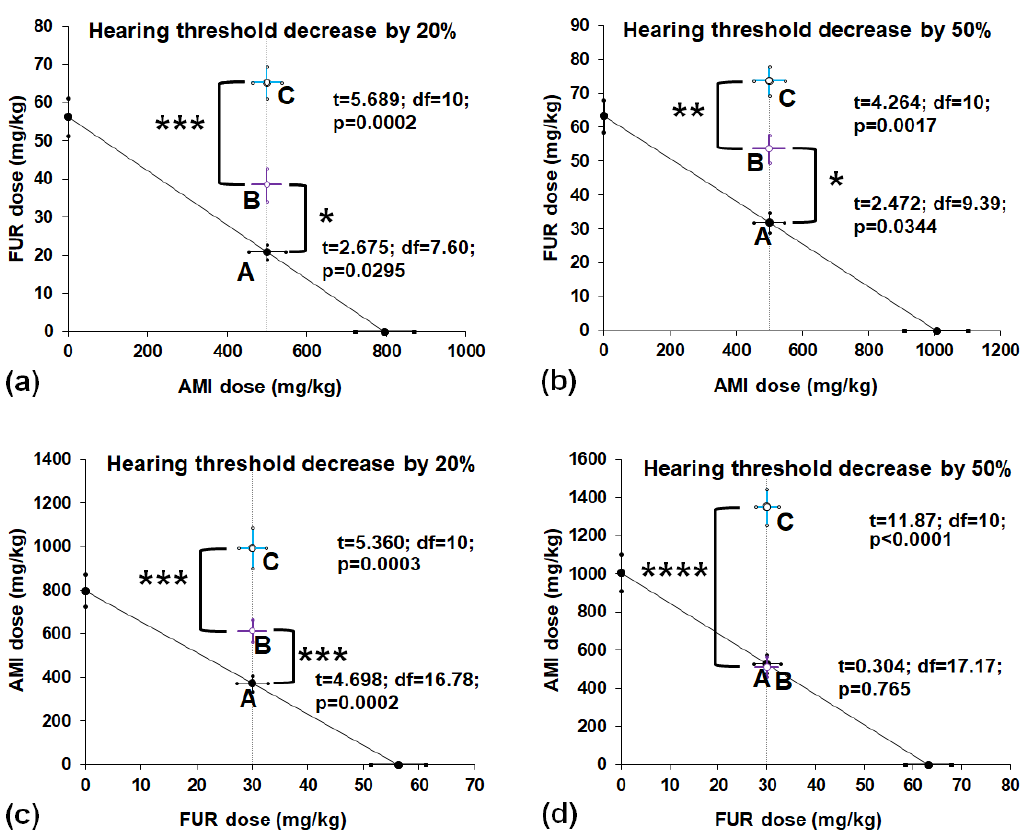
Figure 3. Isobolographic transformation of interaction between AMI and FUR in the drug-induced hearing threshold decrease of 20% and 50% in mice. Doses of AMI and FUR are plotted on the X- and Y-axes, respectively. The dotted line parallel to the Y -axis represents a constant dose of AMI ( a , b ) or FUR ( c , d ), which was added to the increasing doses of FUR or AMI in the mouse model of a hearing threshold decrease of 20% and 50%, respectively. Point A (on each graph) illustrates the theoretically additive dose of the two-drug mixture (AMI+FUR) that could produce a hearing threshold decrease of 20% or 50%, respectively. Point B indicates the dose of AMI and FUR that experimentally evoked a hearing threshold decrease of 20% and 50%, respectively. Point C illustrates the dose of the two-drug mixture producing a hearing threshold decrease of 20% and 50% in animals exposed additionally to NAC (500 mg/kg). * p < 0.05, ** p < 0.01, *** p < 0.001 and **** p < 0.0001 vs. the respective treatment group. NAC—N-acetylcysteine; AMI—amikacin; FUR—furosemide.